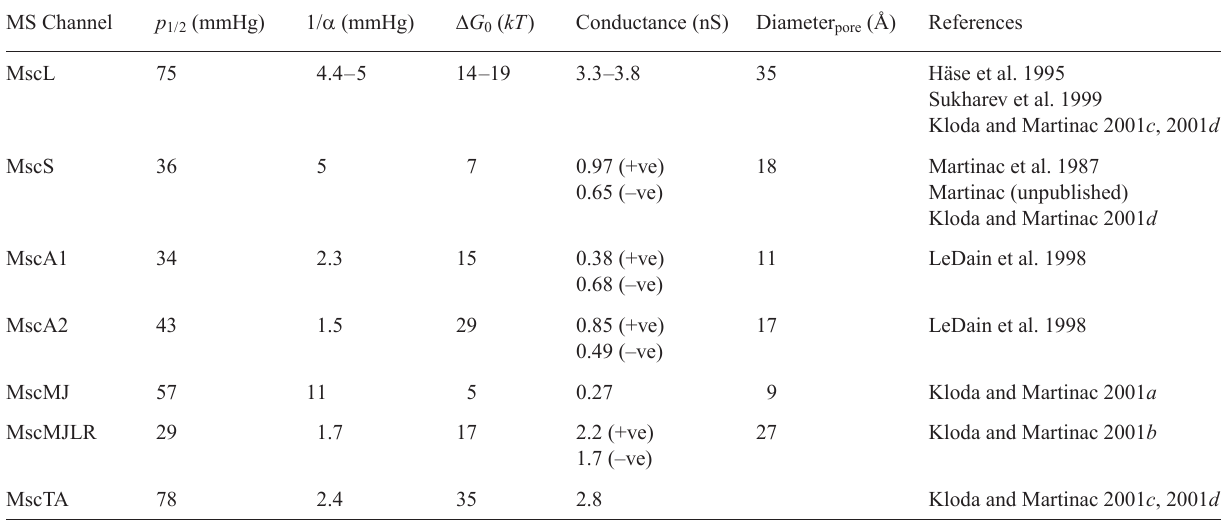
Table 1. Summary of the Boltzmann characteristics and conductive properties for the known prokaryotic MS channels. The parameter values shown were compiled from data cited in the references listed. The conductive and mechanosensitive properties of these channels are further illus- trated in Figures 3 and 4 (adapted from Kloda and Martinac 2001 d ). The diameter of the open channel pore was calculated according to a model proposed by Hille (1968) (Cruickshank et al. 1997). Note: 1 mmHg = 133